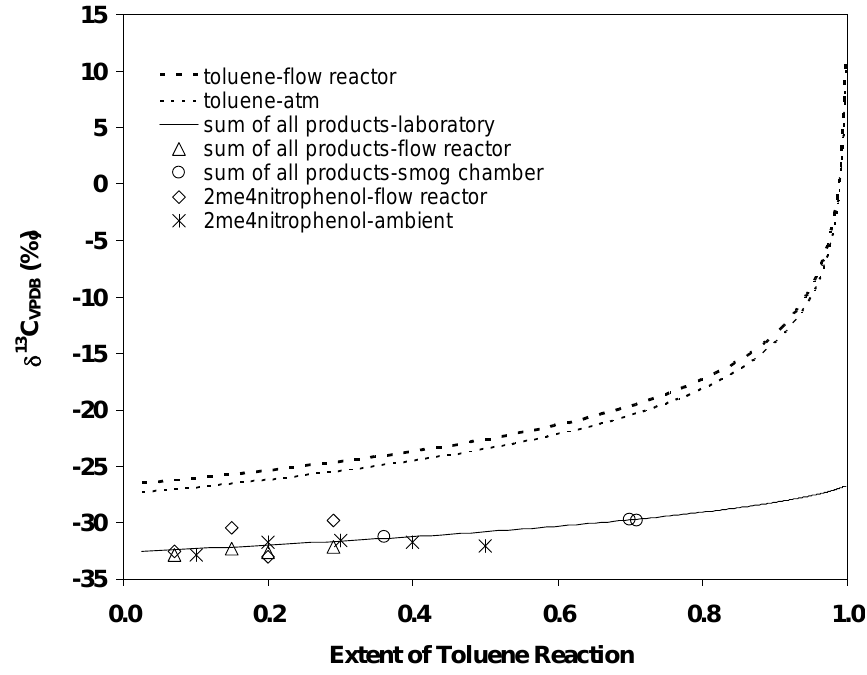
Fig. 4. Stable isotope ratio of toluene and its products as function of toluene processing. The broken lines are calculations based on the initial isotope ratio of toluene. The solid line is the isotope ratio of POM formed by the oxidation of toluene calculated from mass balance under the assumption that there is no fractionation between the phases. Individual data points represent measurements of the carbon isotope ratio of total POM. The flow reactor and smog chamber data are taken from Irei et al. (2006, 2011) and Irei (2008). It should be noted that the position of the ambient 2-methyl-4-nitrophenol data along the x-axis does not indicate the extent of toluene processing. Spreading out the data is done for the purpose of indicating the extent of variability as well as to show that these data are consistent with laboratory observations up to at least 30% of toluene